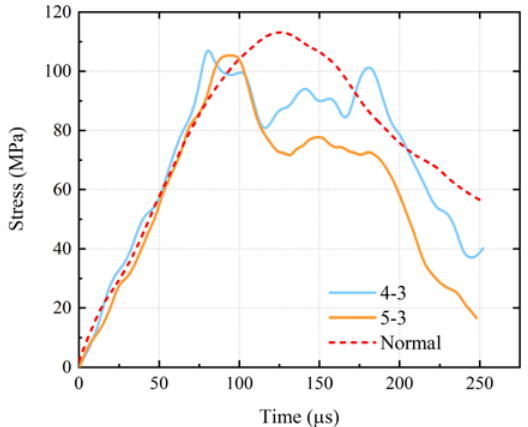
Figure 10. The stress–time curves for specimen 4-3 and 5-3.